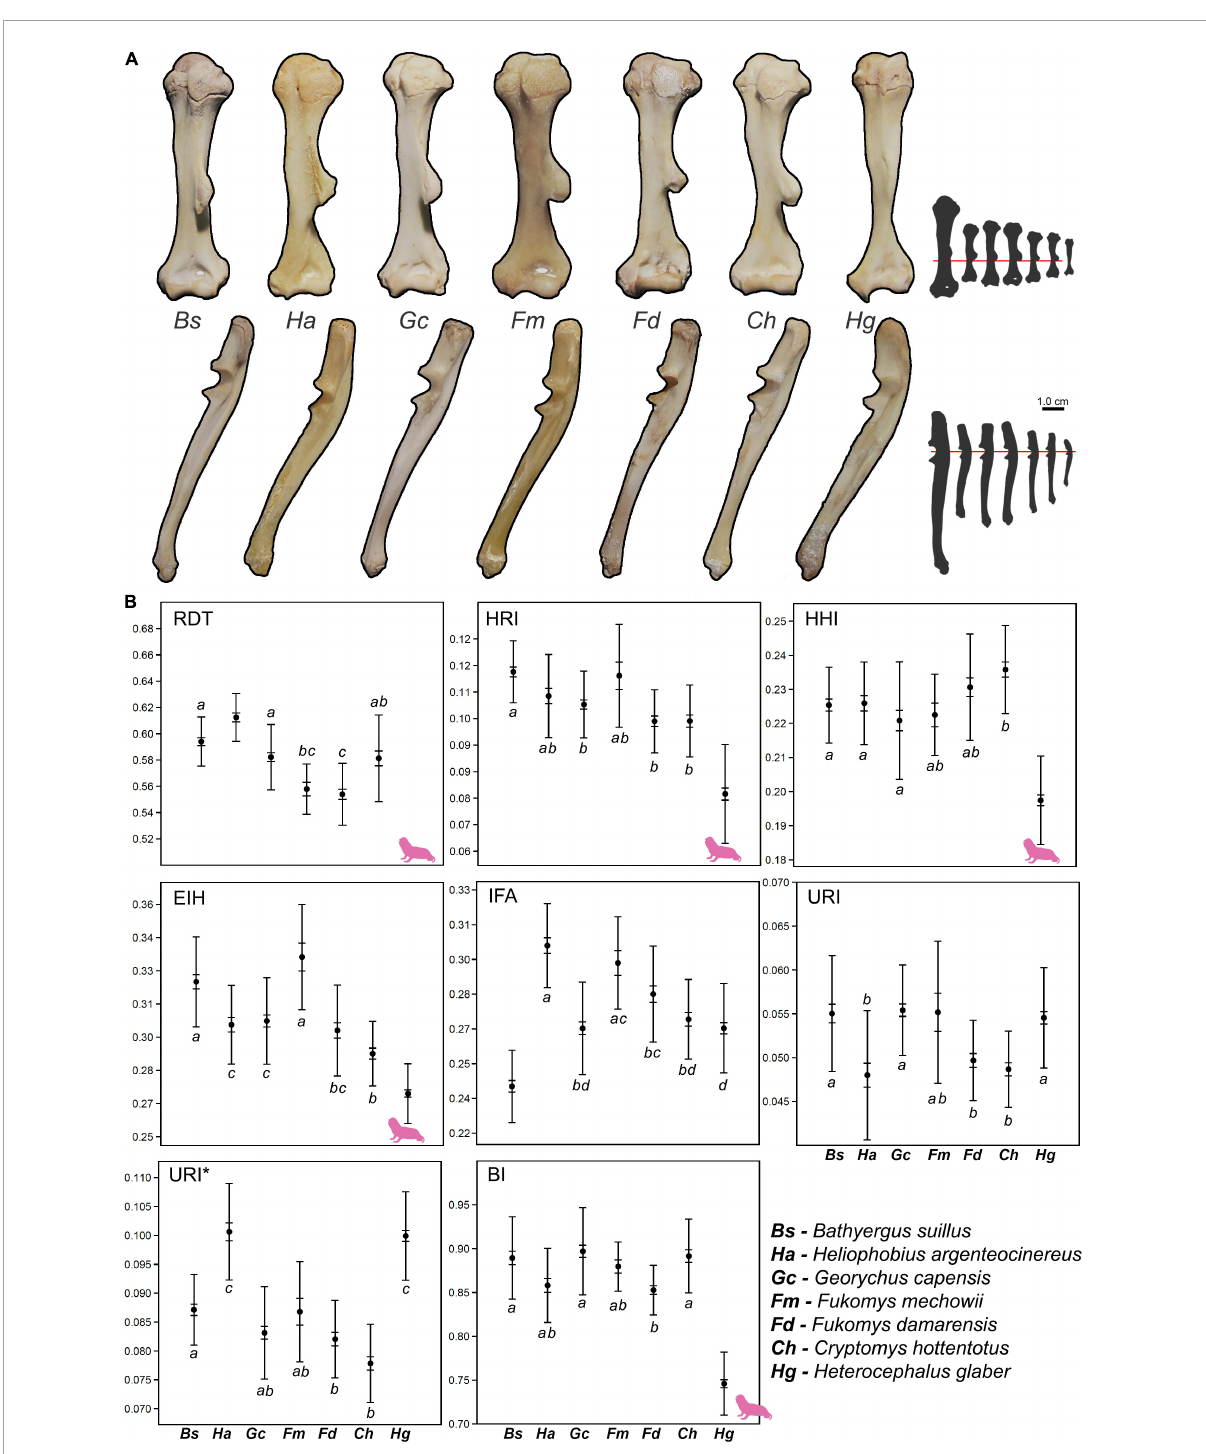
FIGURE3 Quantification of the forelimb morphology (humerus and ulna). (A) Humeral (top row) and ulnar (bottom row) morphology of all species. Bones scaled to same size to emphasize differences in bone shape. Small bone silhouettes show the real relative size of bones between species. The humeri are aligned to the distal origin of the deltoid tuberosity (except in Heterocephalus glaber ), while the ulnae are aligned to the center of the trochlear notch. (B) Whisker plots showing differences among species. Mean (central point), s.e (short whiskers) and s.d. (long whiskers). Species that share the same letter represent homogeneous subsets, as identified by post hoc (Tamhane) tests. The pink silhouette represents H. glaber and indicates the indices for which this species differs significantly from other bathyergids, as well as the indices not measured for this species (i.e. lack of morphological specialization). Taxa are primarily ordered from solitary to social species, and secondarily from the largest to the smallest species. Abbreviation of indices in Table 2